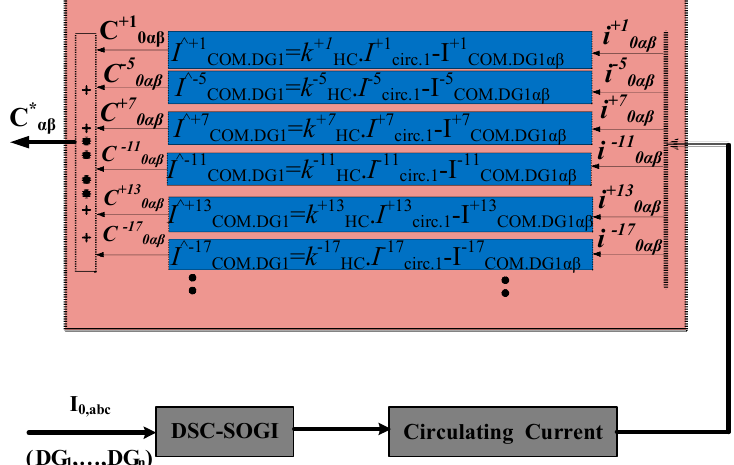
Figure 4. Harmonic current sharing controller .